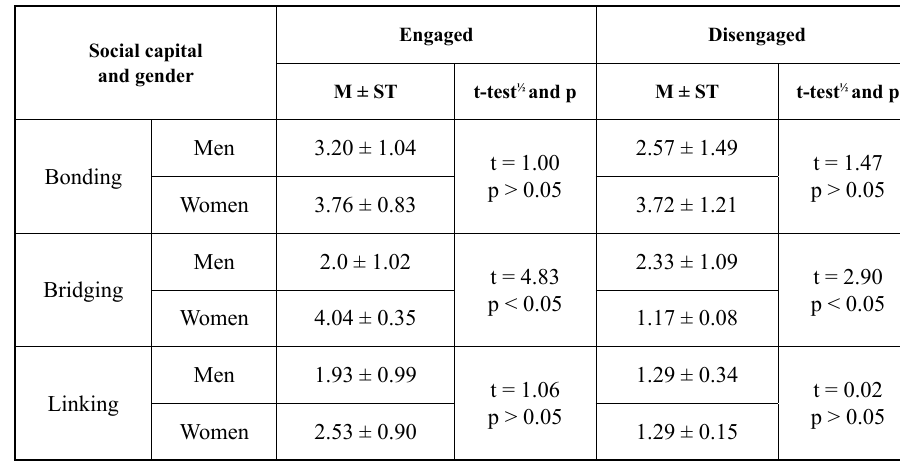
Note. Values are expressed as mean ± SD. Significant differences were set by in- dependent samples Student’s t-test among groups: 1 – men, 2 –